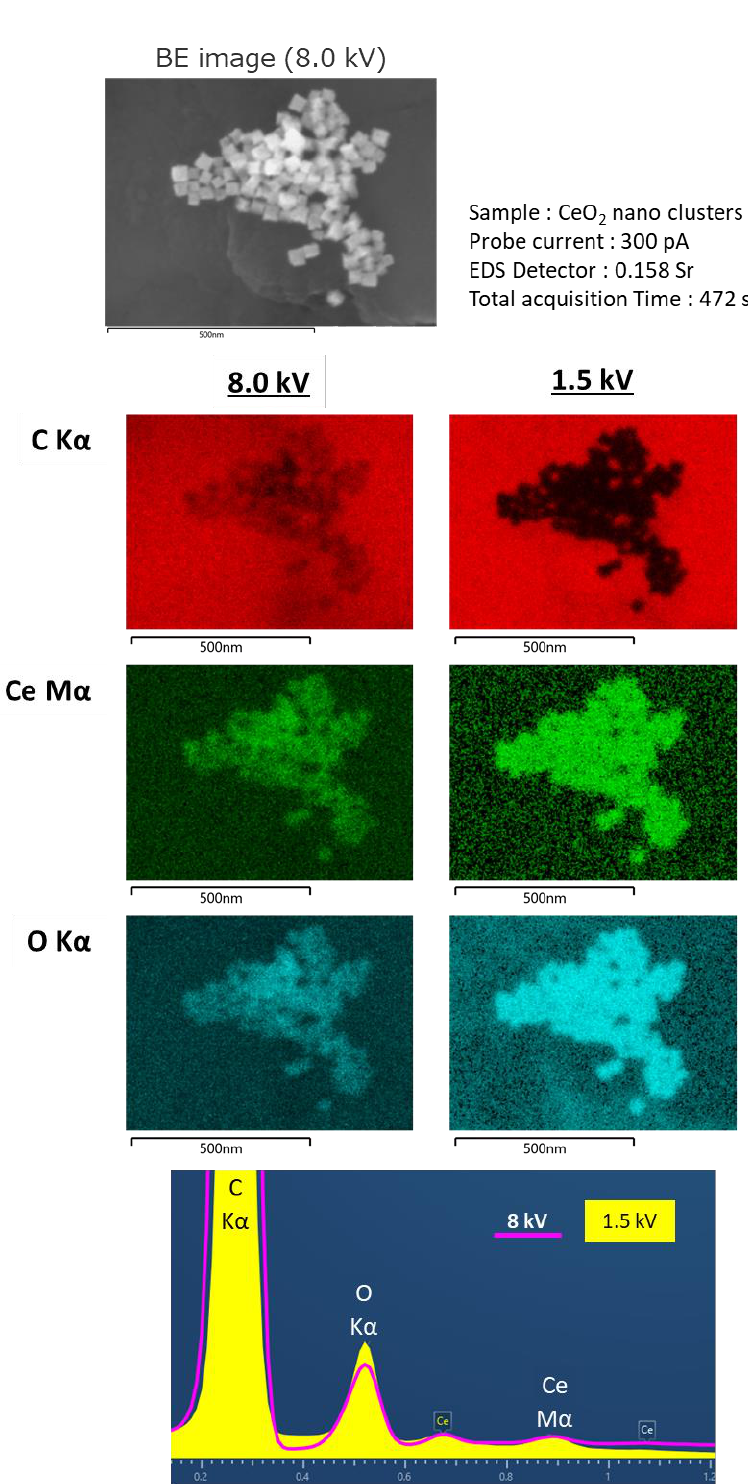
Figure 6. Results of large solid angle Energy Dispersive X-ray Spectroscopy (EDS).